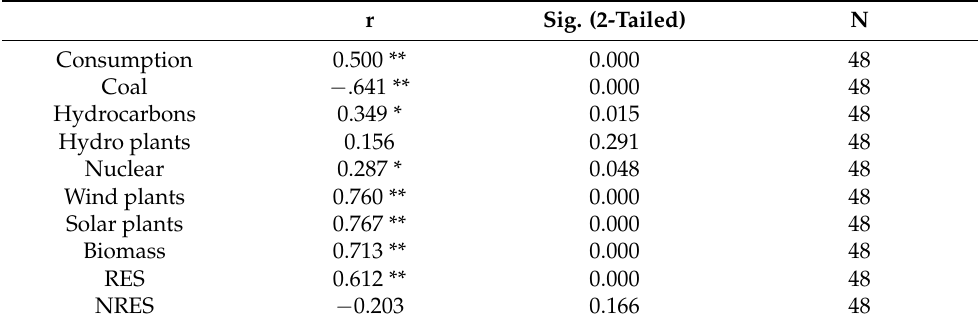
Table 7. Pearson correlation between GDP and electricity produced from different types of fuels, between Q1 2008 and Q4